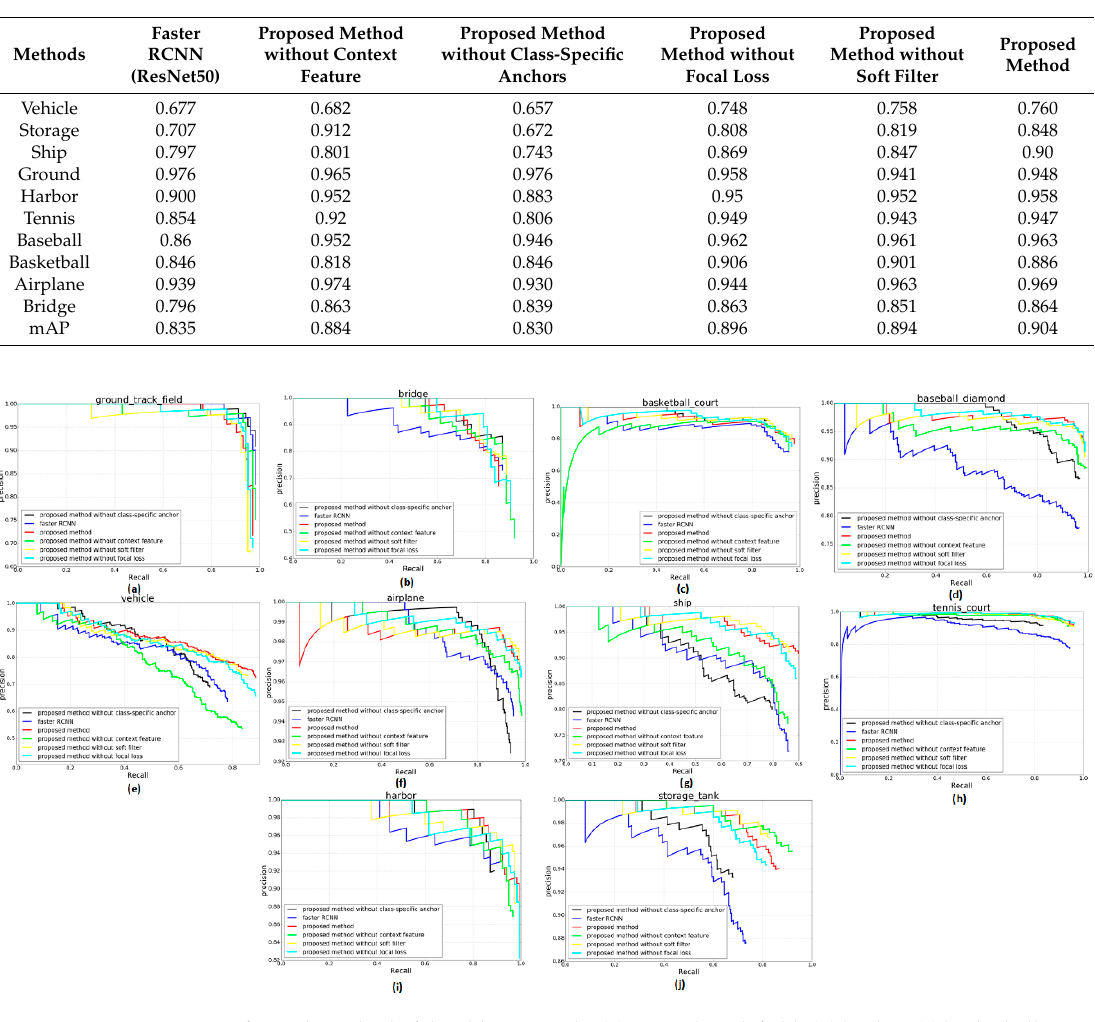
Figure 11. PR-Curve for each method of the ablation study. ( a ) ground track field. ( b ) bridge. ( c ) basketball court. ( d ) baseball diamond. ( e ) vehicle. ( f ) airplane. ( g ) ship. ( h ) tennis court. ( i ) harbor. ( j ) storage tank.